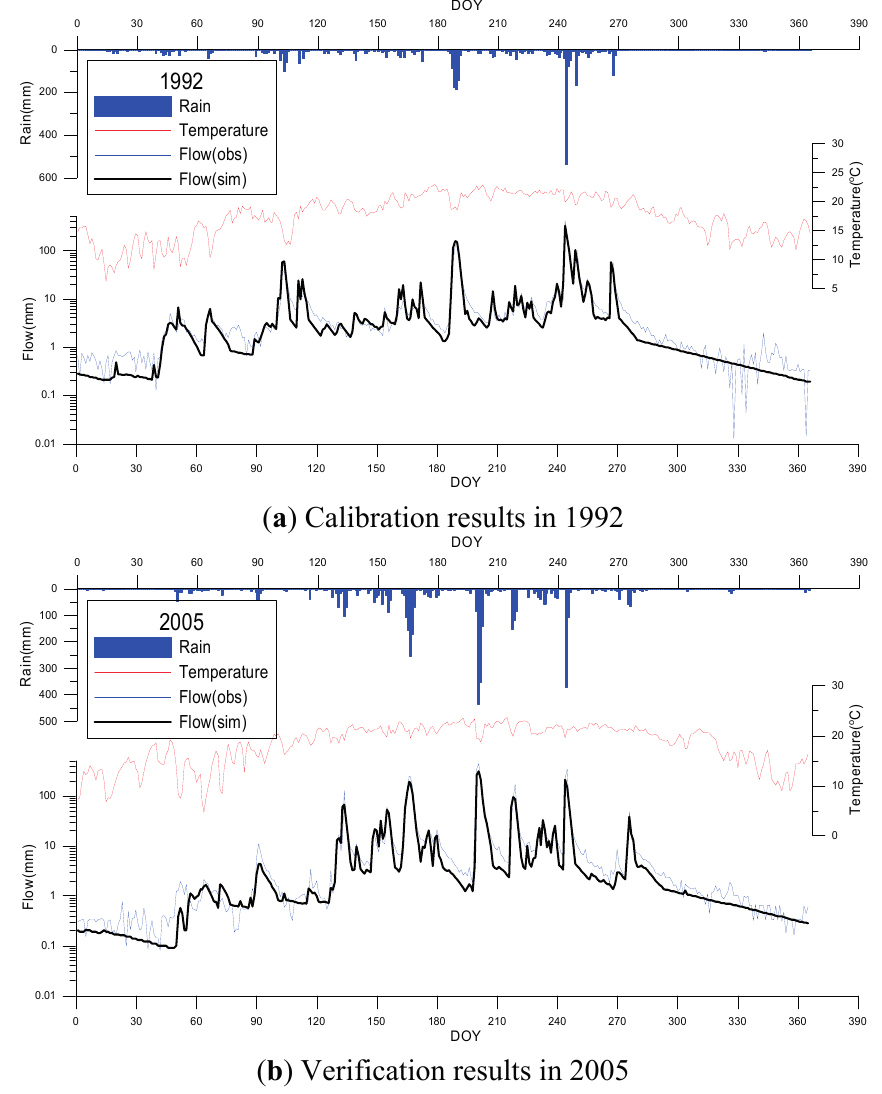
Figure 5. Calibration and verification results for the HBV-based model in ( a ) 1992 and ( b ) 2005, respectively (DOY: Day of Year).